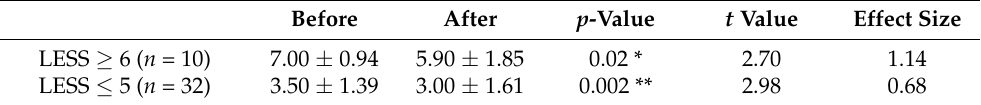
Table 4. Subgroup analysis of the high- and low-risk groups before and after taping. Before After